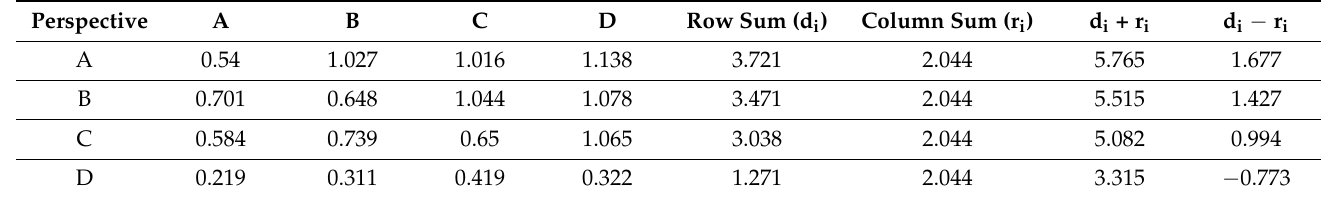
Table 2. Total-influence matrix matrix T : four